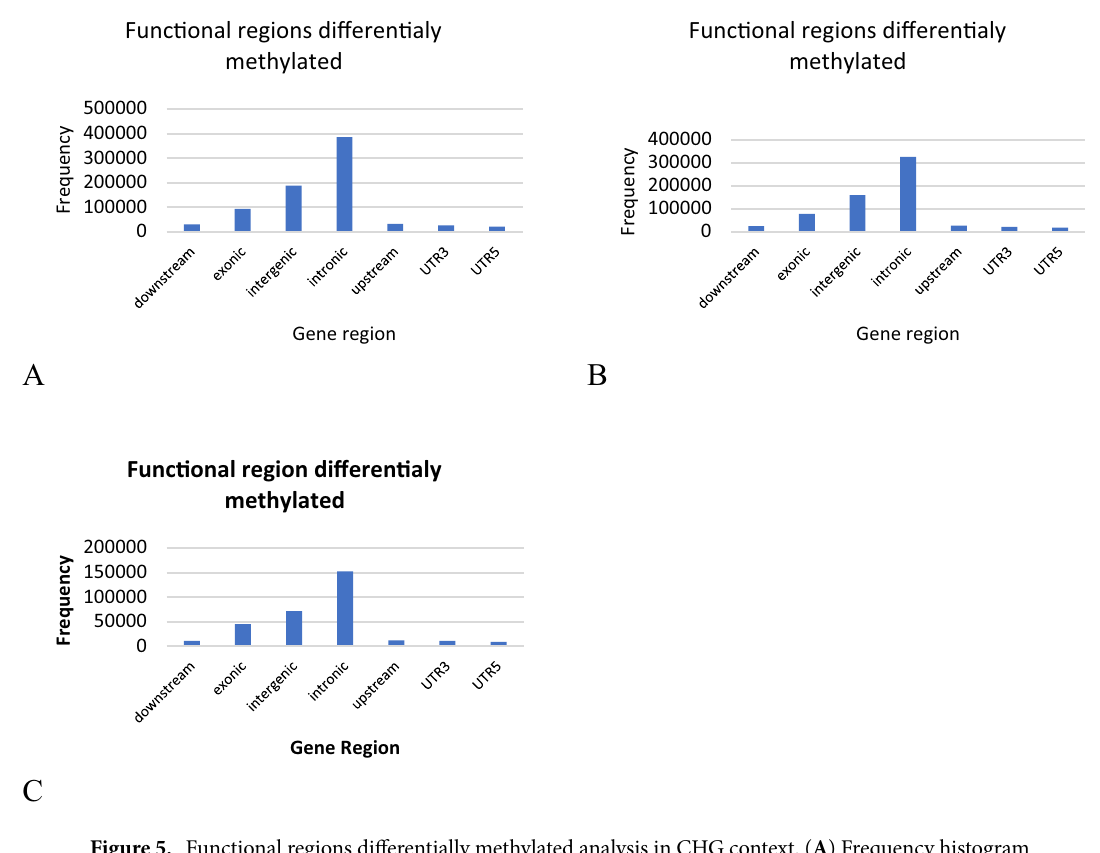
Figure 5. Functional regions differentially methylated analysis in CHG context. ( A ) Frequency histogram representing the functional regions differentially methylated between ZE and normal SE, ( B ) ZE and abnormal SE and ( C ) normal and abnormal SE, where intronic and intergenic regions have the highest